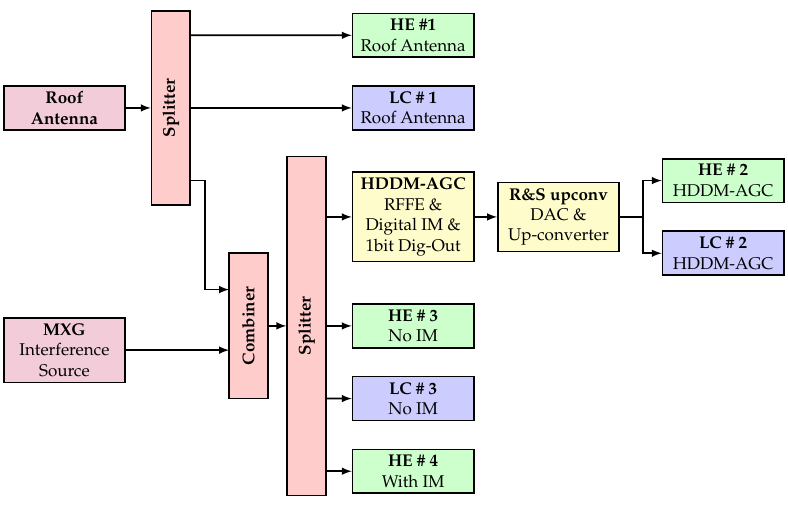
Figure 3. Experimental